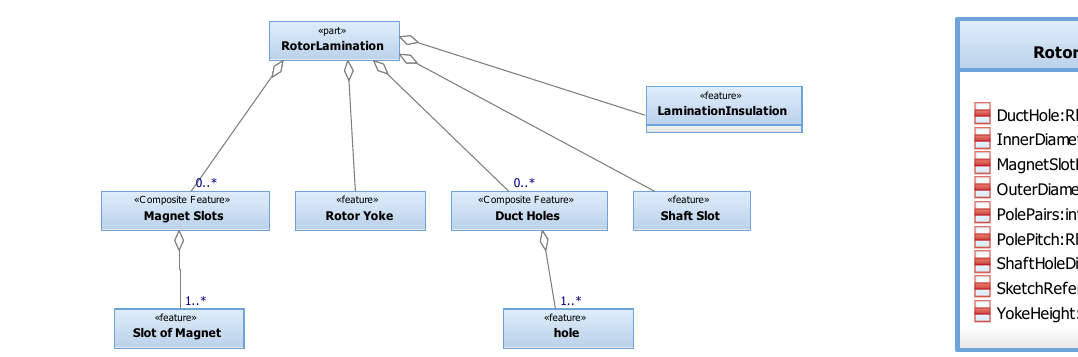
Figure 5. eMachine product model example for the rotor lamination.